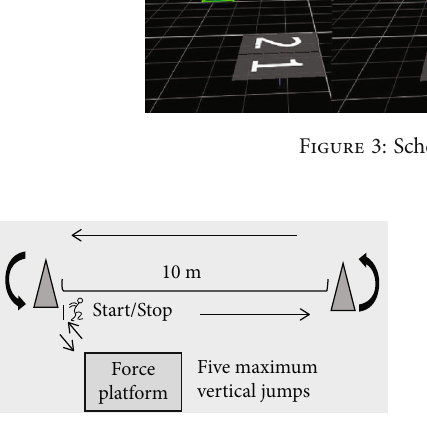
Figure 4: Schematic diagram of fatigue intervention